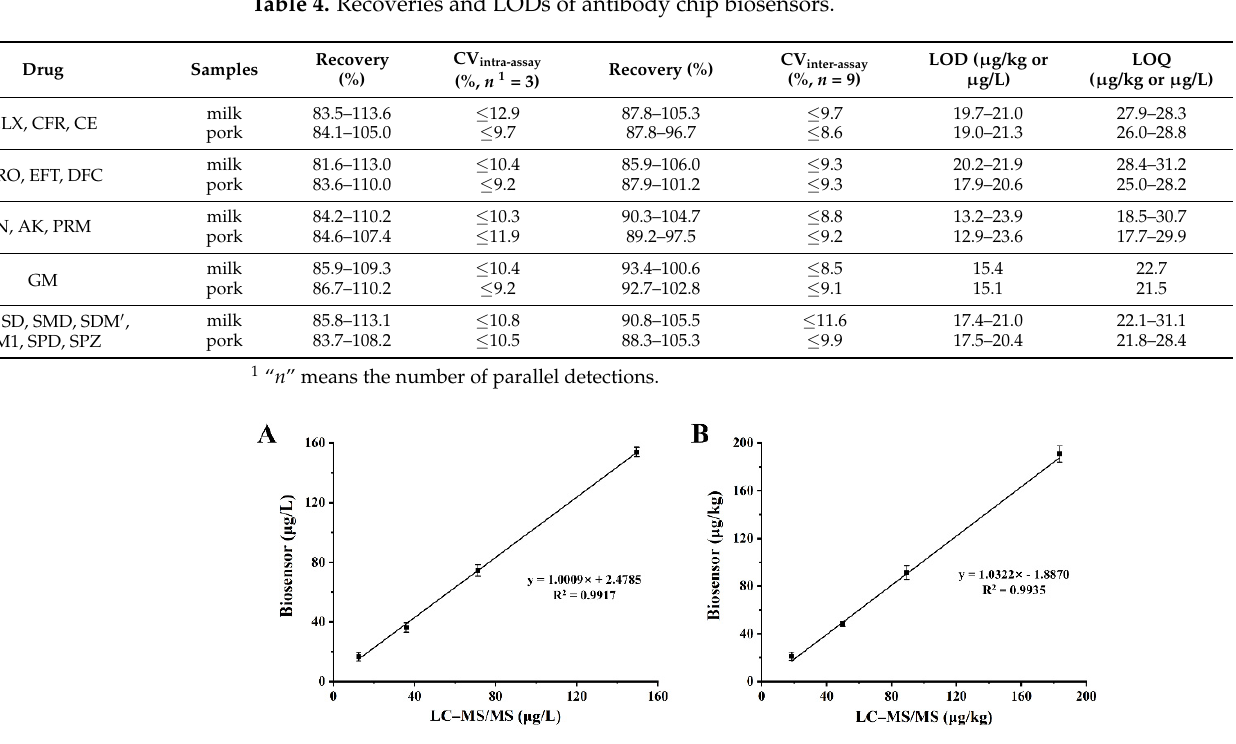
Table 4. Recoveries and LODs of antibody chip biosensors.